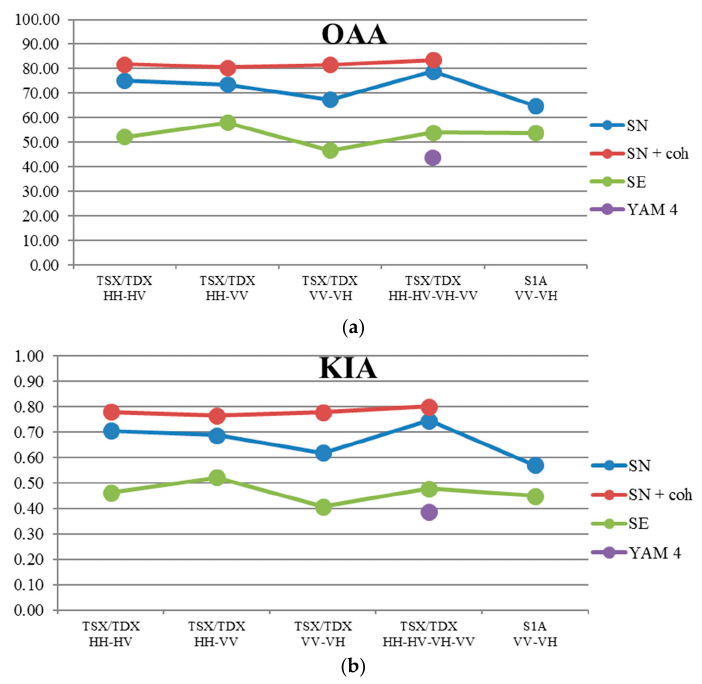
Figure 12. The results of the accuracy assessment for the S1A and the TSX/TDX datasets: ( a ) overall accuracy—OAA, ( b ) Kappa Index of Agreement—KIA.